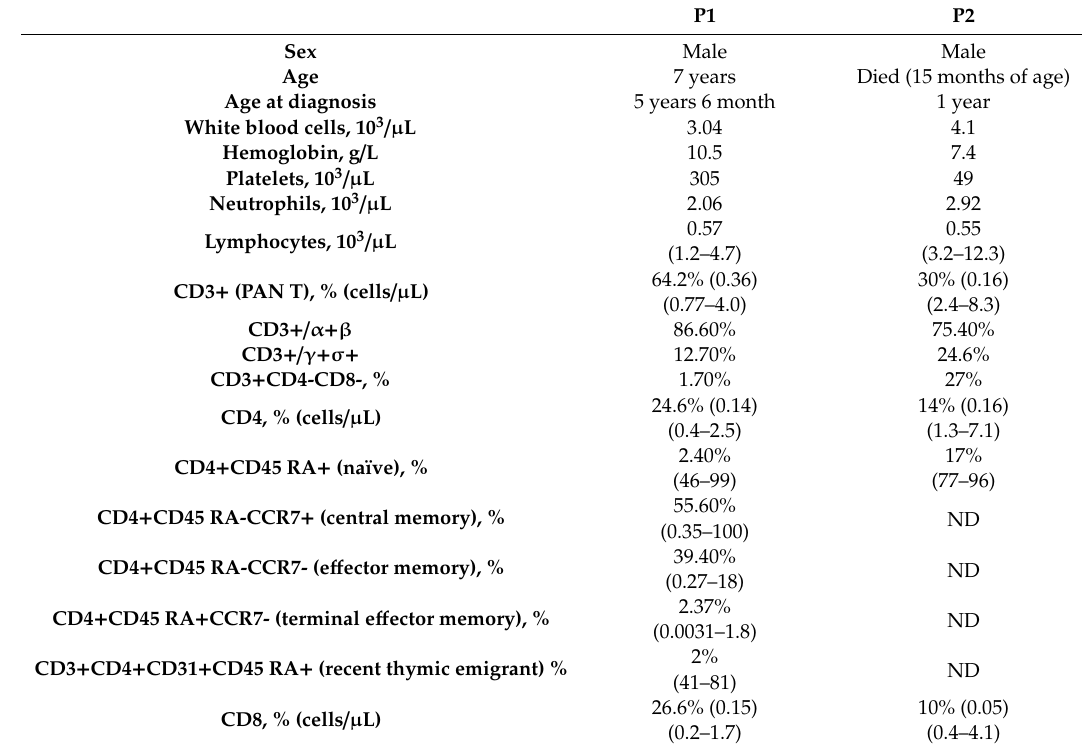
Table 3. Immunological features of patients P1 and